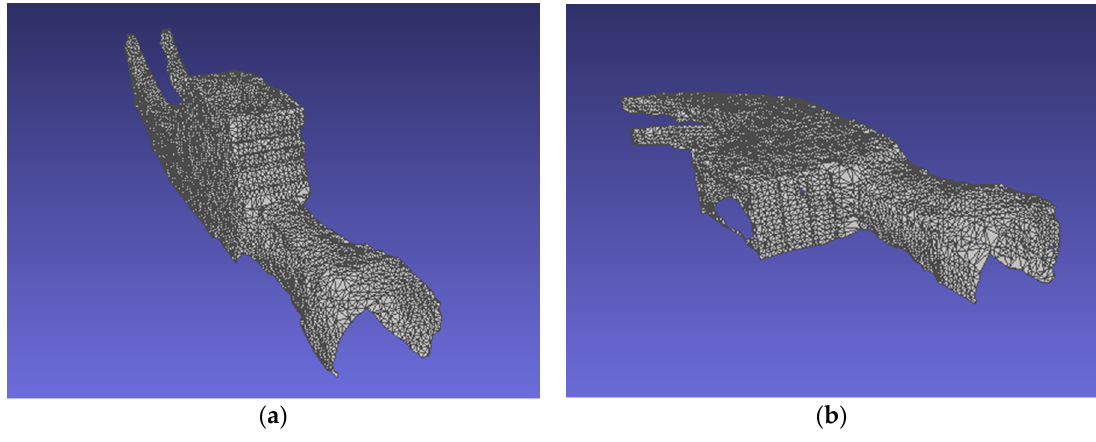
Figure 1. Illustration of two series of scans with missing parts of object surfaces. ( a ) Triangle mesh of series of scans 1; ( b ) Triangle mesh of series of scans 2.